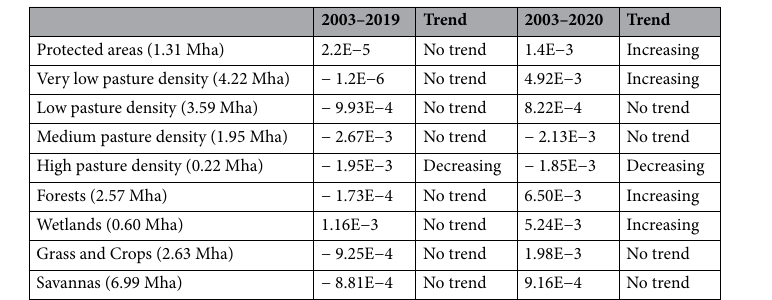
Table 1. Slope of the trendlines of monthly fraction of burned area over areas (month −1 ) with different levels of pasture density and land cover type. The statistical significance of the trends is also indicated in the